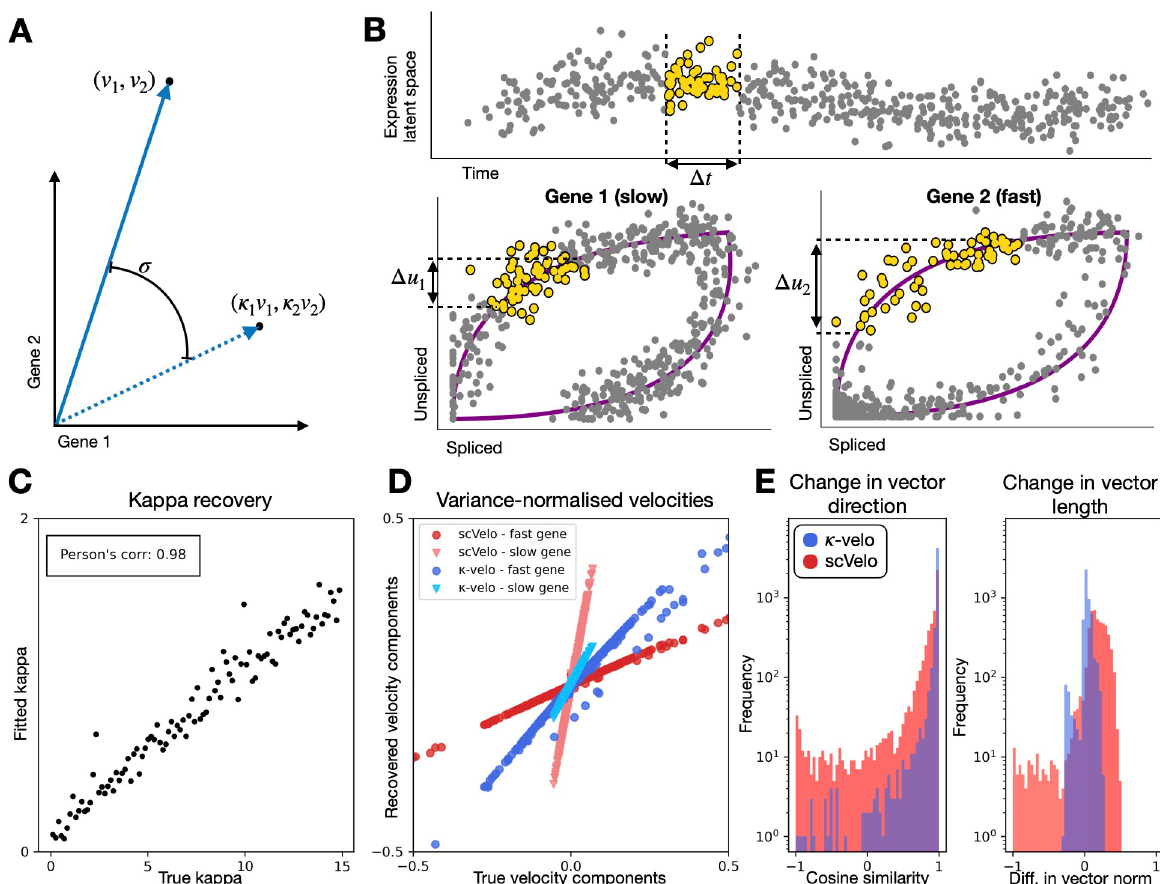
Fig 3. Scaling of gene-wise velocity components. A . If the gene-wise velocities are incorrectly scaled the high-dimensional velocity vector will change direction (displacement angle θ ). B . We propose to use cell densities as a proxy of time. For a same time interval, the displacement in u will be proportional to a gene’s speed. This allows us to relate velocities across genes and solve the scale invariance problem. C . To validate κ -velo, we simulate splicing kinetics scaled by a scaling factor κ and evaluate how well the factors are recovered. D . We compare the κ -velo and scVelo velocities to the true velocities for two genes with different speeds. The high-dimensional velocity vectors are normalised to have equal variance for ease of comparison. E . The high-dimensional vector is projected on the first two principal components to evaluate differences between true velocities and recovered velocities. We return the change in direction (cosine similarity) and length (difference in vector norm) (Note J in S1 Appendix) for κ -velo and scVelo. To make the length comparable, the vectors are variance-normalised. Note the log-scale for